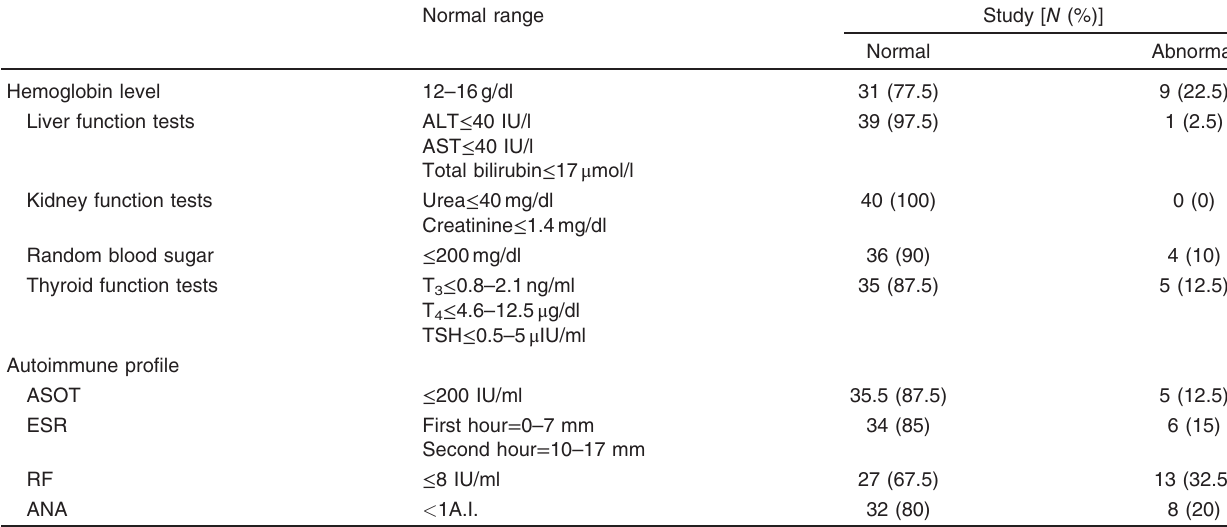
Table 2 The laboratory data for the study